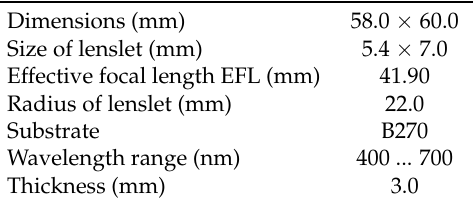
Table 1. Specifications of the lens array.